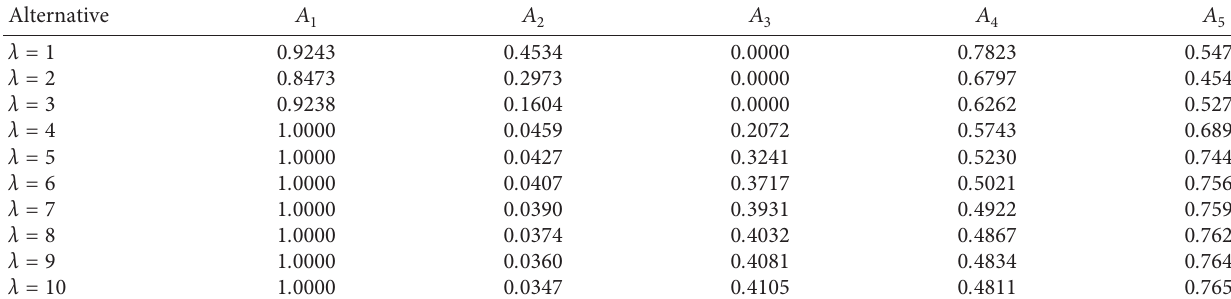
Table 15: The compromise index MC